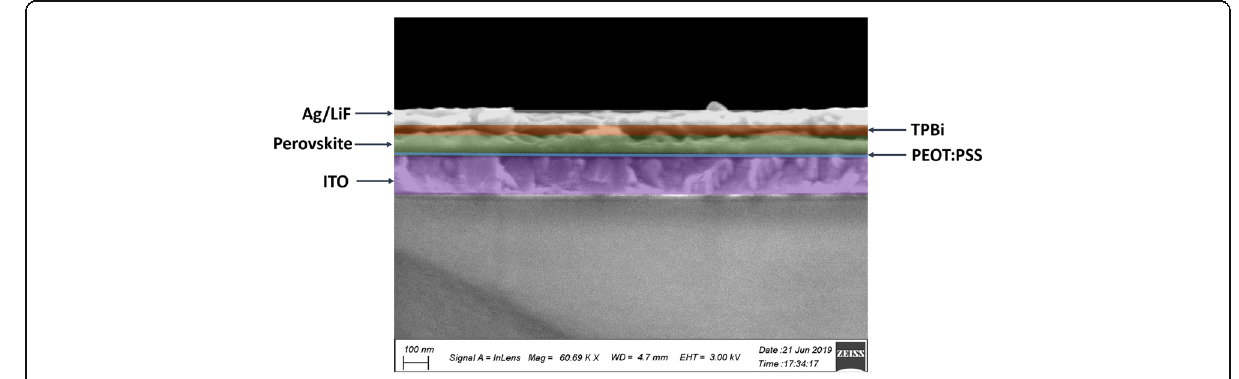
Fig. 5 Cross-sectional field-emission SEM of a quasi-2D